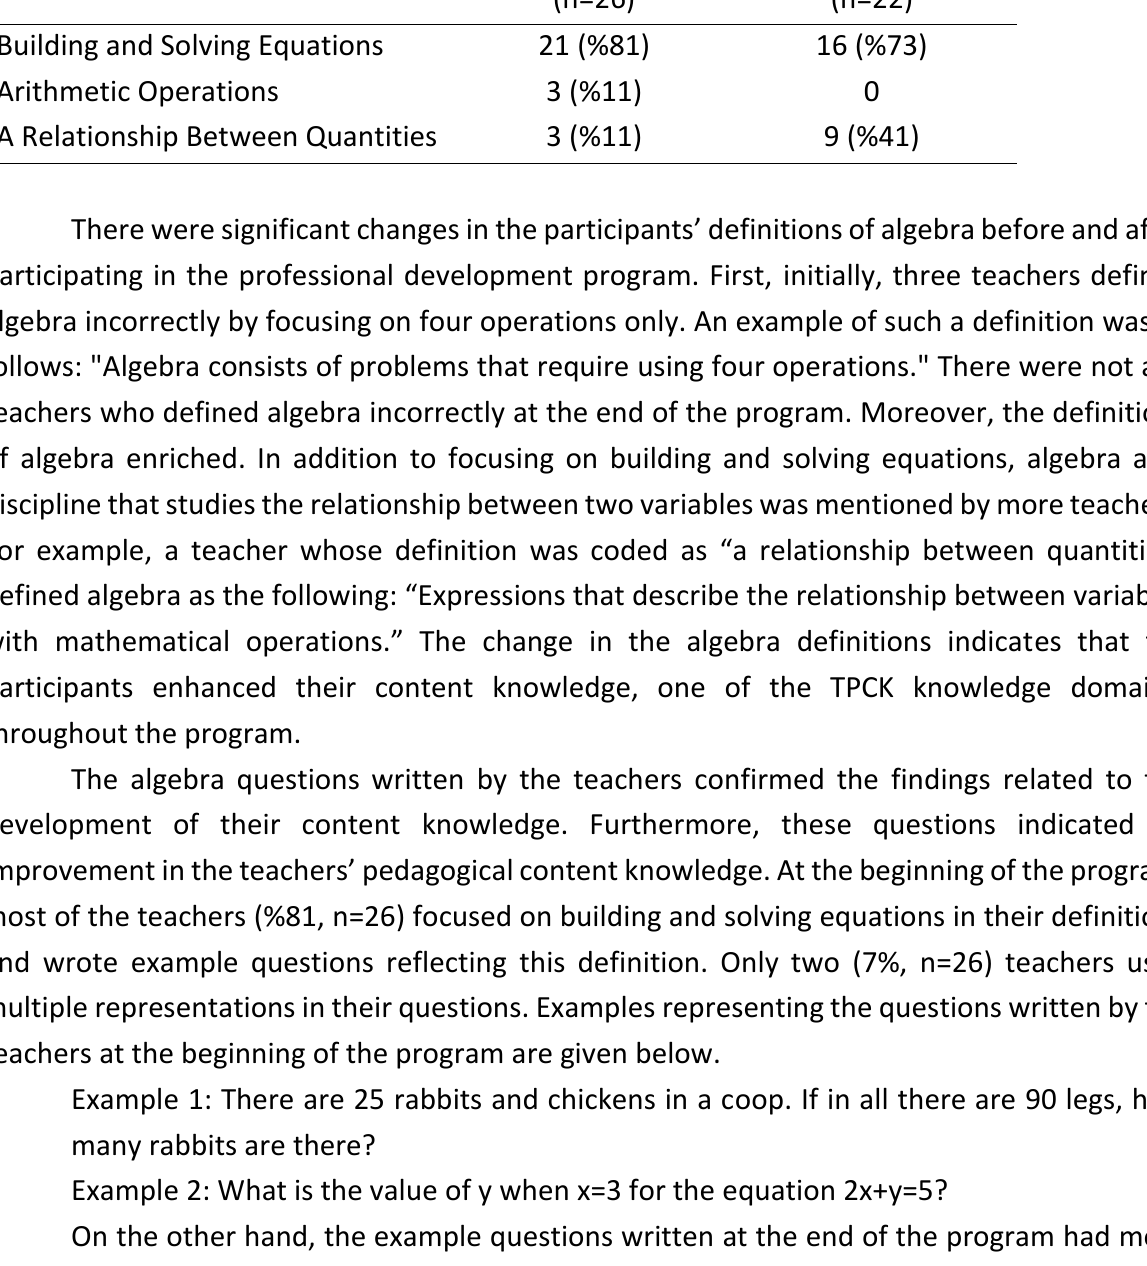
Table 4. Teachers' Algebra Definitions Before and After the Program The Focus of the Definition At the Beginning Building and Solving Equations 21 (%81) 16 (%73) Arithmetic Operations 3 (%11) 0 A Relationship Between Quantities 3